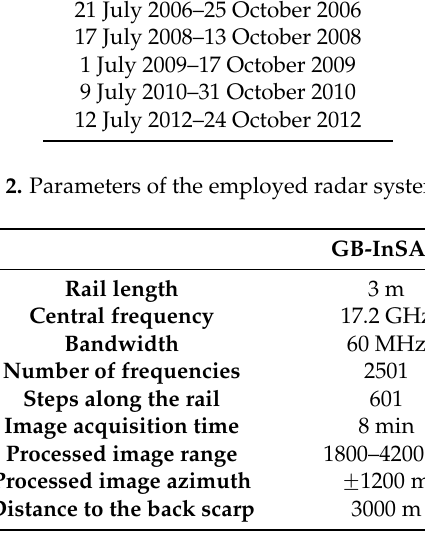
Table 2. Parameters of the employed radar system